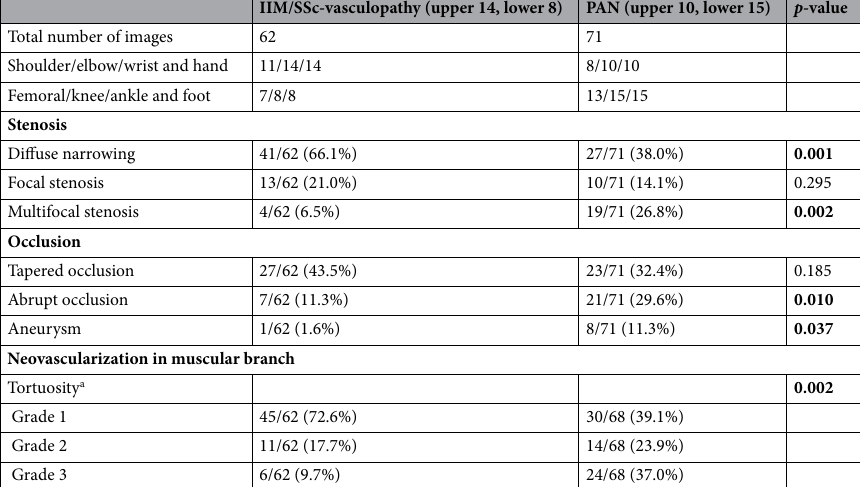
Table 2. Comparison of angiographic parameters between IIM/SSc-vasculopathy and PAN. IIM idiopathic inflammatory myopathies, PAN polyarteritis nodosa, SSc systemic sclerosis. Significant values are in bold. a Tortuosity grade 1, normal; grade 2, mild to moderate; grade 3, severe (hypertortuosity). Data are expressed as number (%) of images.